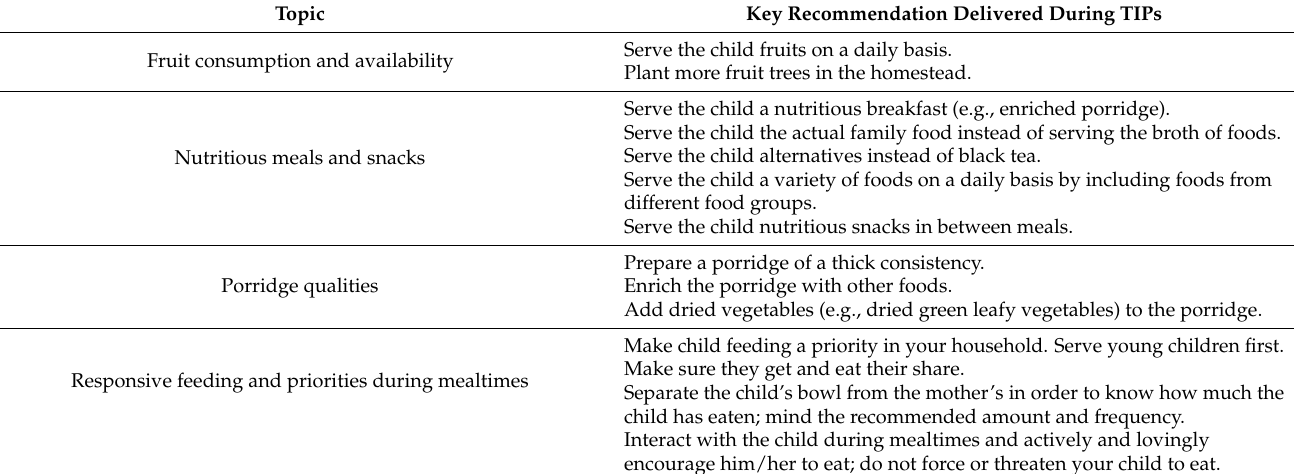
Table 1. Key recommendations on child feeding practices tested during the Trials of Improved Practices (TIPs). Topic Key Recommendation Delivered During TIPs Fruit consumption and